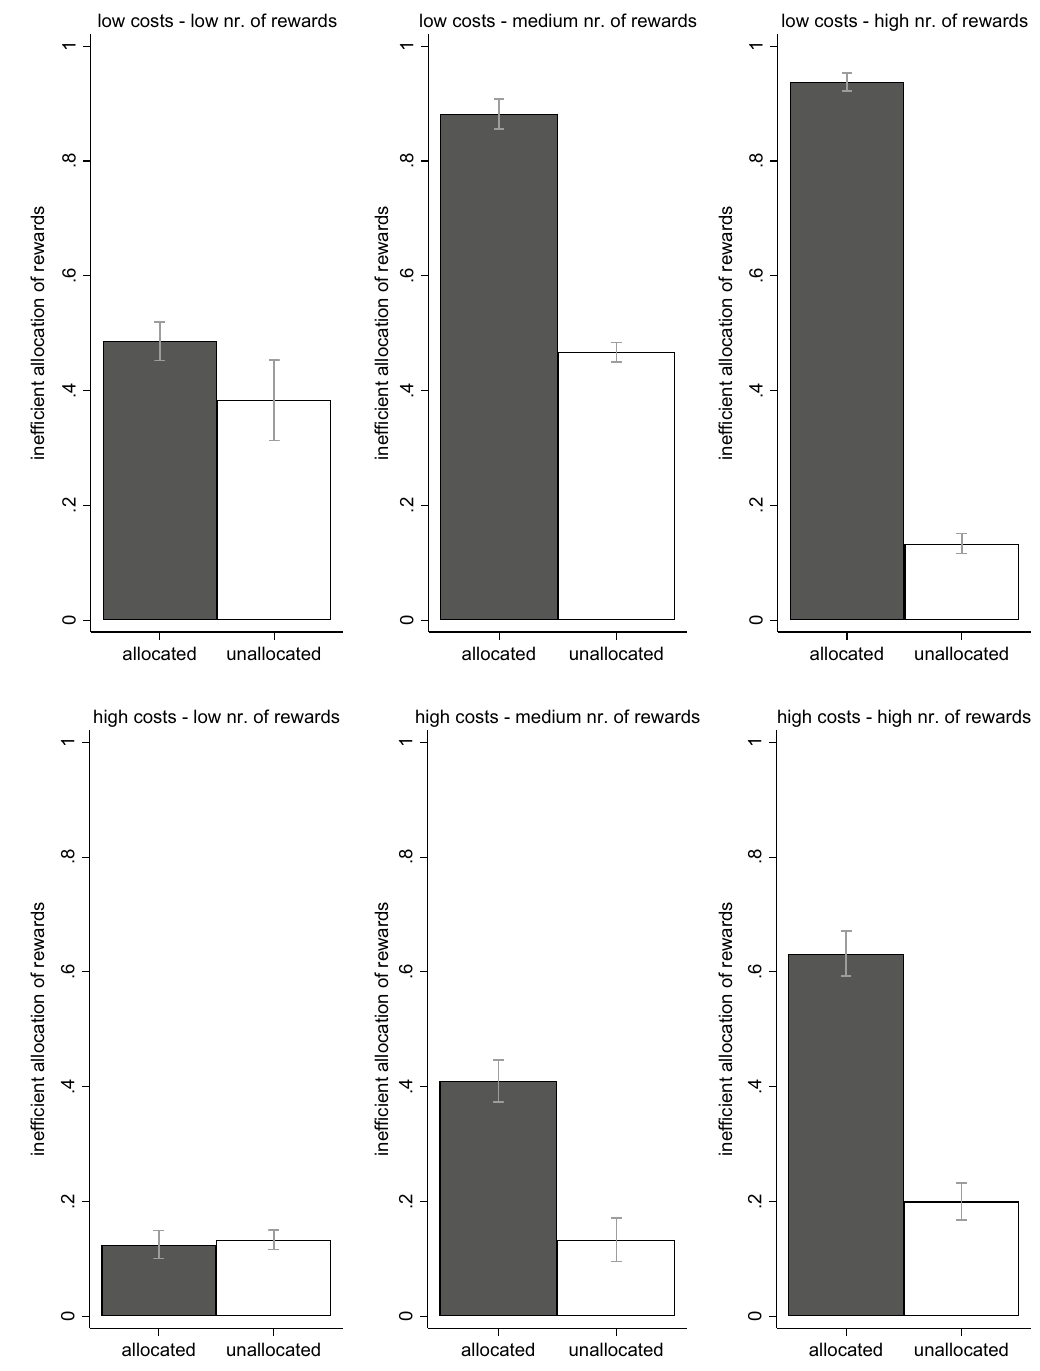
Figure 2. The observed efficiency of reward allocation by condition. For both conditions, the outcome variable is a collective inefficiency score that indicates the proportion of members in the group that would need to change their competition decision in order to achieve the collectively efficient allocation of rewards. Hence, the score has a theoretical minimum of 0 and maximum of 1. 95% confidence intervals are included. We observe higher inefficiency in the allocated condition than in the unallocated condition for 5 of the 6